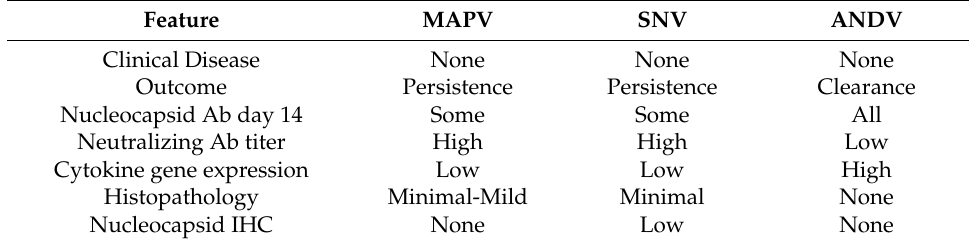
Table 2. Comparison of MAPV, Sin Nombre virus (SNV), and Andes virus (ANDV) infection of deer mice. Traits in boldface reflect those most similar to SNV or ANDV infection of deer mice. Feature MAPV SNV ANDV Clinical Disease None None